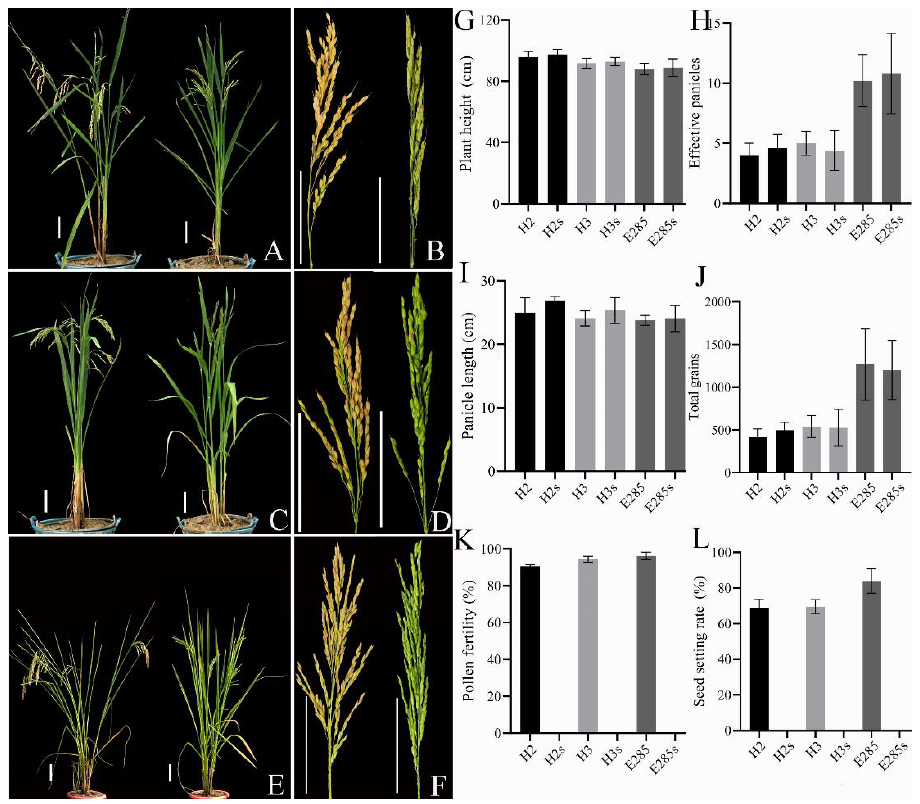
Figure 2. Identification of morphological and agronomic traits of TMS5 mutants in the field. ( A ) The plant type of wild-type and TMS5 mutant of H2. ( B ) Mature panicles of wild-type and TMS5 mutant of H2. ( C ) The plant type of wild-type and TMS5 mutant of H3. ( D ) Mature panicles of wild-type and TMS5 mutant of H3. ( E ) The plant type of wild-type and TMS5 mutant of E285. ( F ) Mature panicles of E285. Bars = 10 cm. ( G ) Plant height of WT and TMS5 mutant. ( H ) Effective number of panicles of WT and TMS5 mutant. ( I ) Panicle length of WT and TMS5 mutant. ( J ) Total number of grains of WT and TMS5 mutant. ( K ) Seed setting rate of WT and TMS5 mutant. ( L ) Pollen fertility of WT and TMS5 mutant; Five plants of WT and TMS5 mutants were selected.